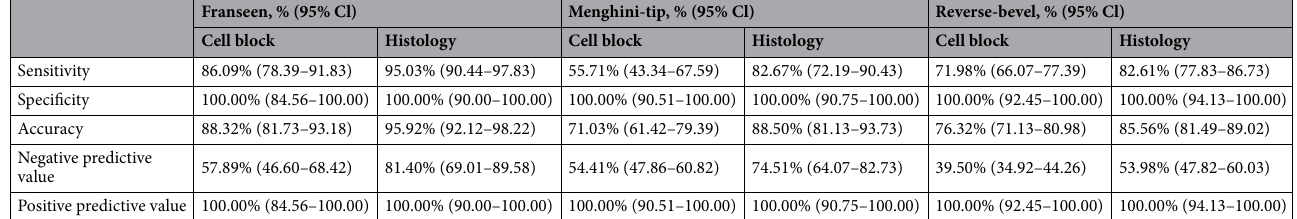
Table 3. Diagnostic performance according to the needles. Cl, confidence